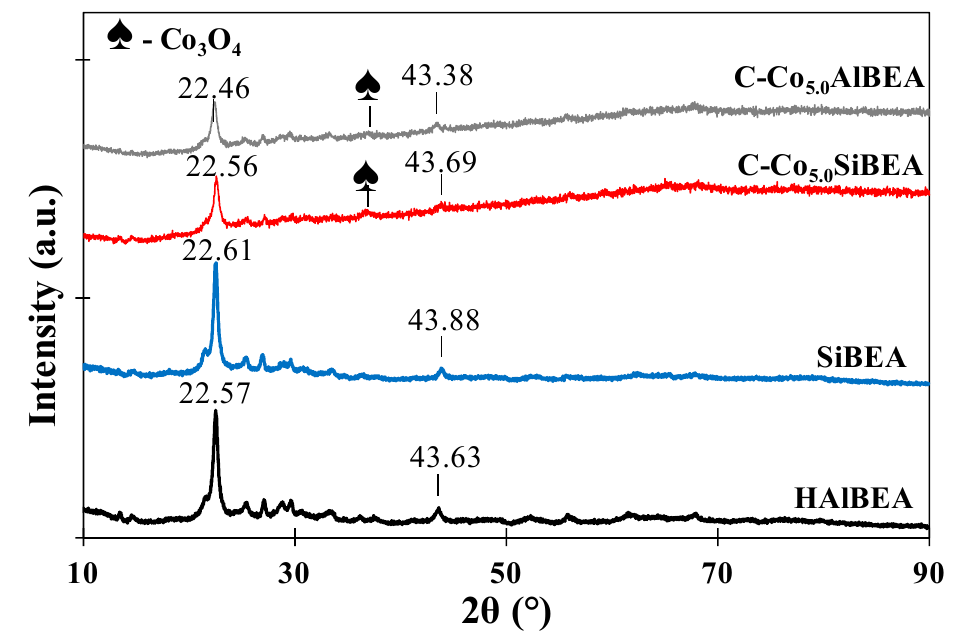
Figure 1. XRD diffractograms of HAlBEA, SiBEA, C-Co 5.0 AlBEA and C-Co 5.0 SiBEA showing contraction of the zeolite matrix after dealumination and expansion after incorporation of Co cations.